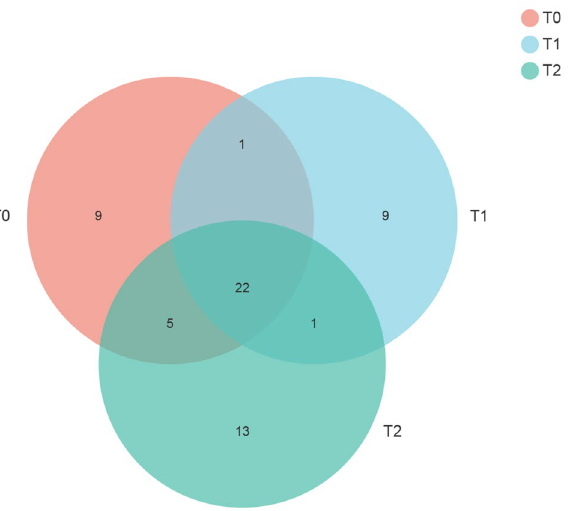
Figure 3. Venn diagram depicts operational taxonomic units (OTUs) of soil ammonia-oxidizing archaea (AOA) that were shared or unique for T 0 , T 1 , and T 2 . Notes : T 0 = Traditional irrigation; T 1 = Traditional irrigation and fertilization practice; T 2 = Water-saving irrigation and optimizing fertilization.